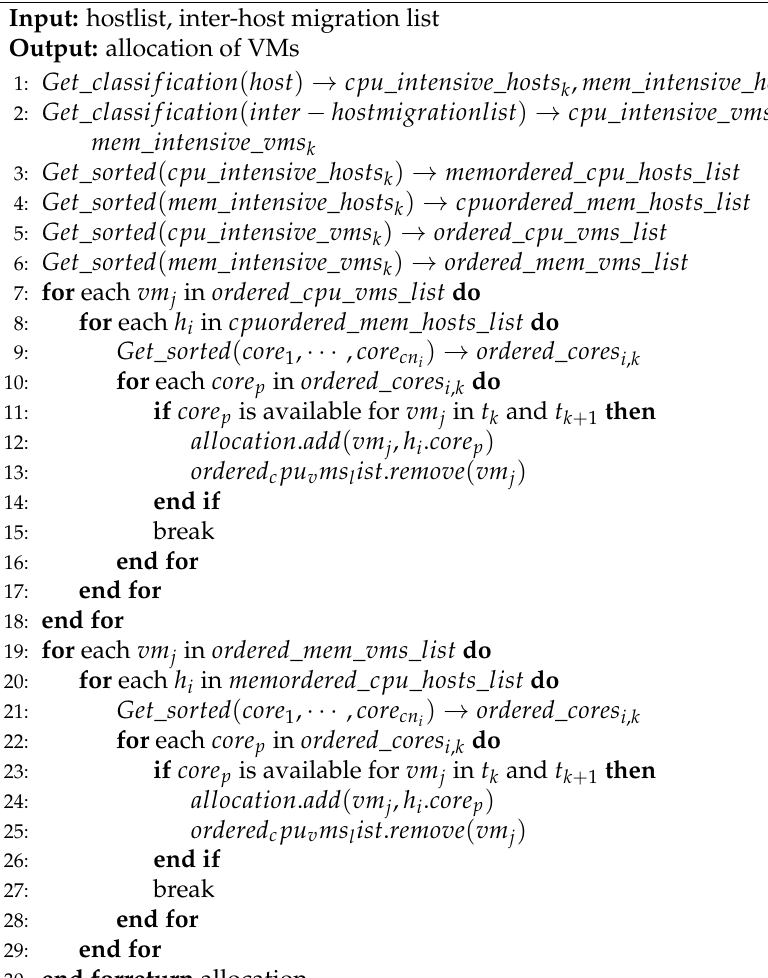
Algorithm 2 Inter-Host VM Placement